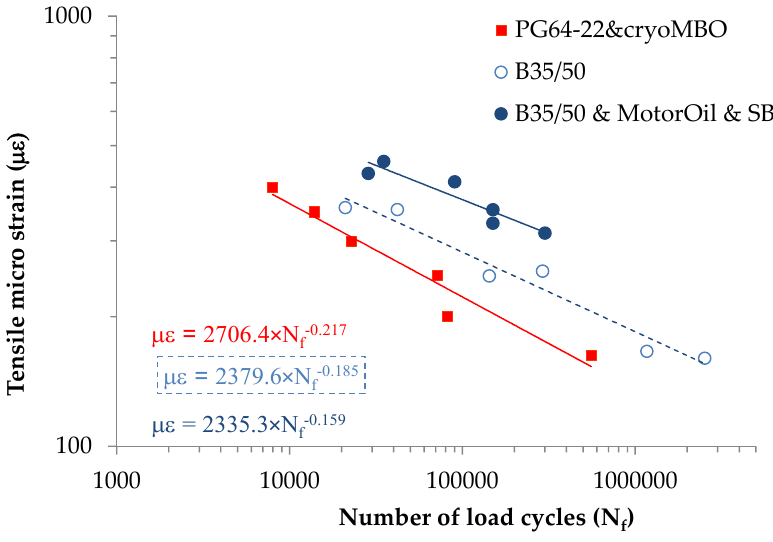
Figure 3. Variation in the number of loading cycles (N f ) before fatigue failure with the tensile micro strain ( με ) applied in the fatigue test for the studied mixtures.